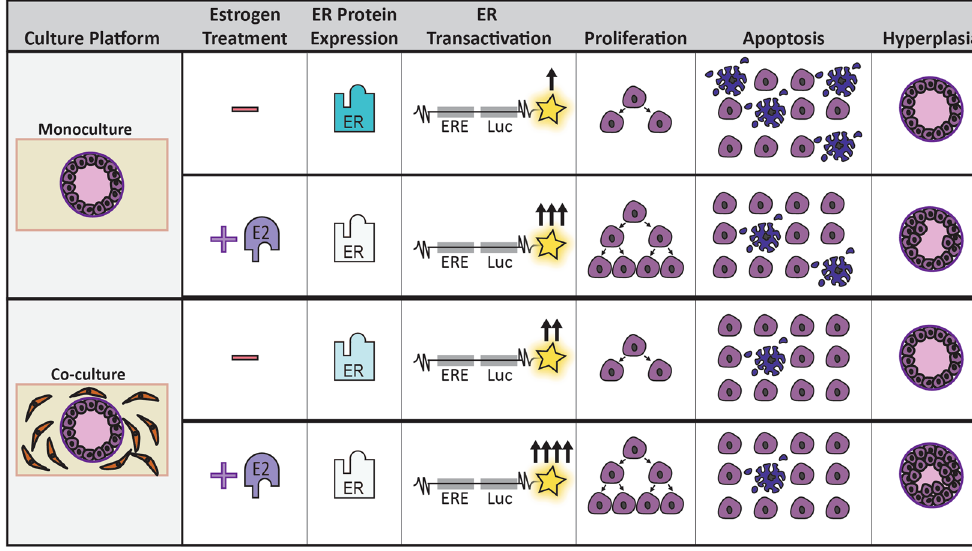
Figure 7. Graphical summary of major findings in the